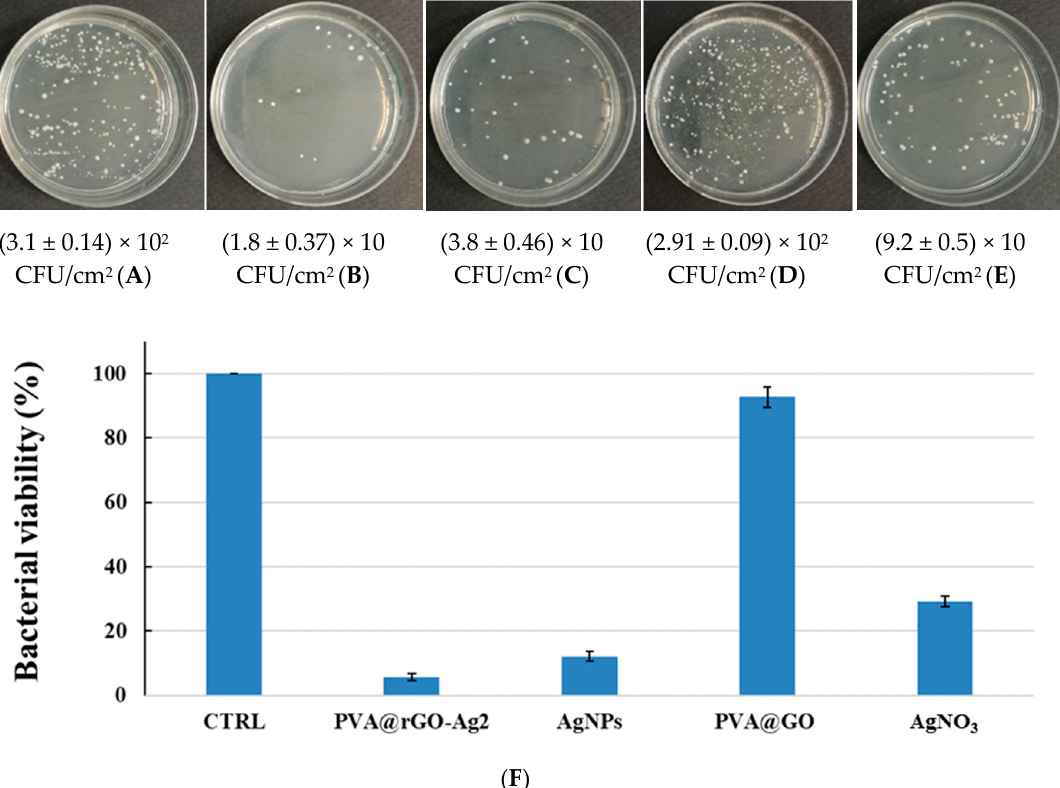
Figure 7. Antibacterial assay in plate count agar after 24 h of incubation: ( A ) Control experiment (CTRL); ( B ) PVA@rGO-Ag2; ( C ) AgNPs; ( D ) PVA@GO; ( E ) AgNO 3 ; ( F ) viability percentage. The deviation standard in CFU / cm 2 has been derived from triplicate test. The CFU for cm 2 of sampling surface (CFU / cm 2 ) values were calculated from Equation